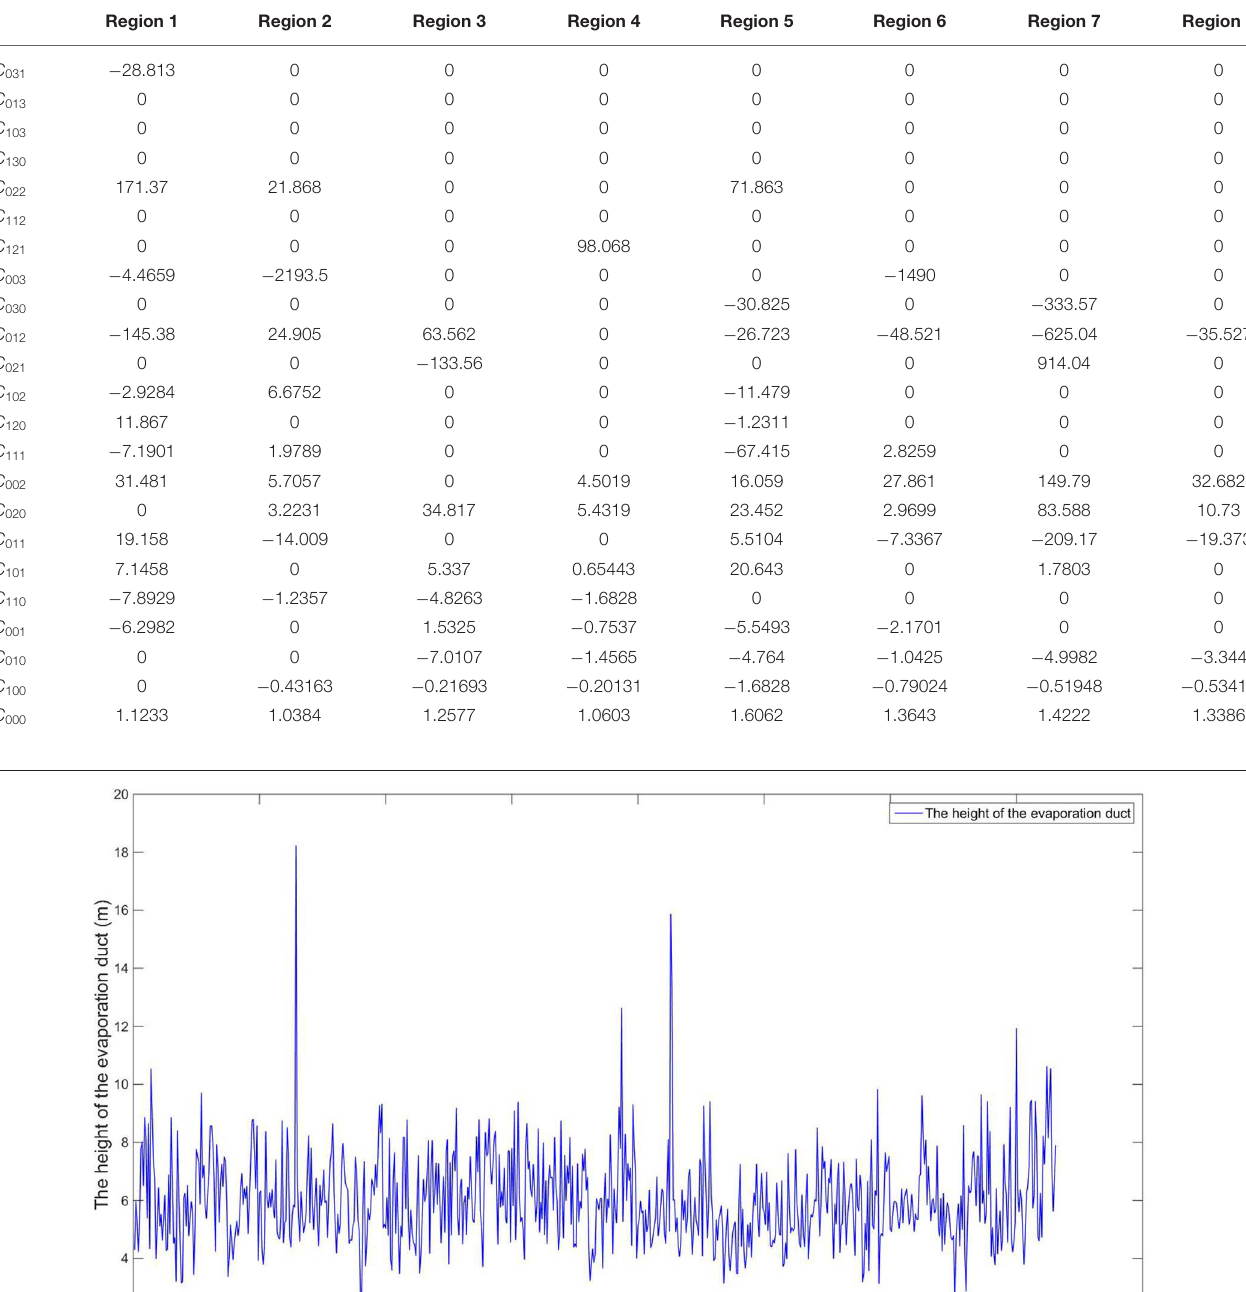
TABLE 5 | Coefficients of Equation (8) for category 1. Region 1 Region 2